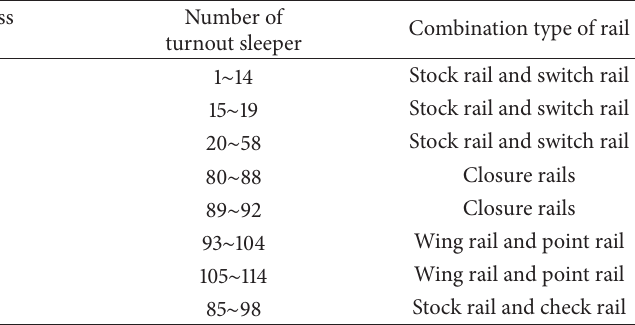
Table 2: Redesign of pad stiffness under shared base